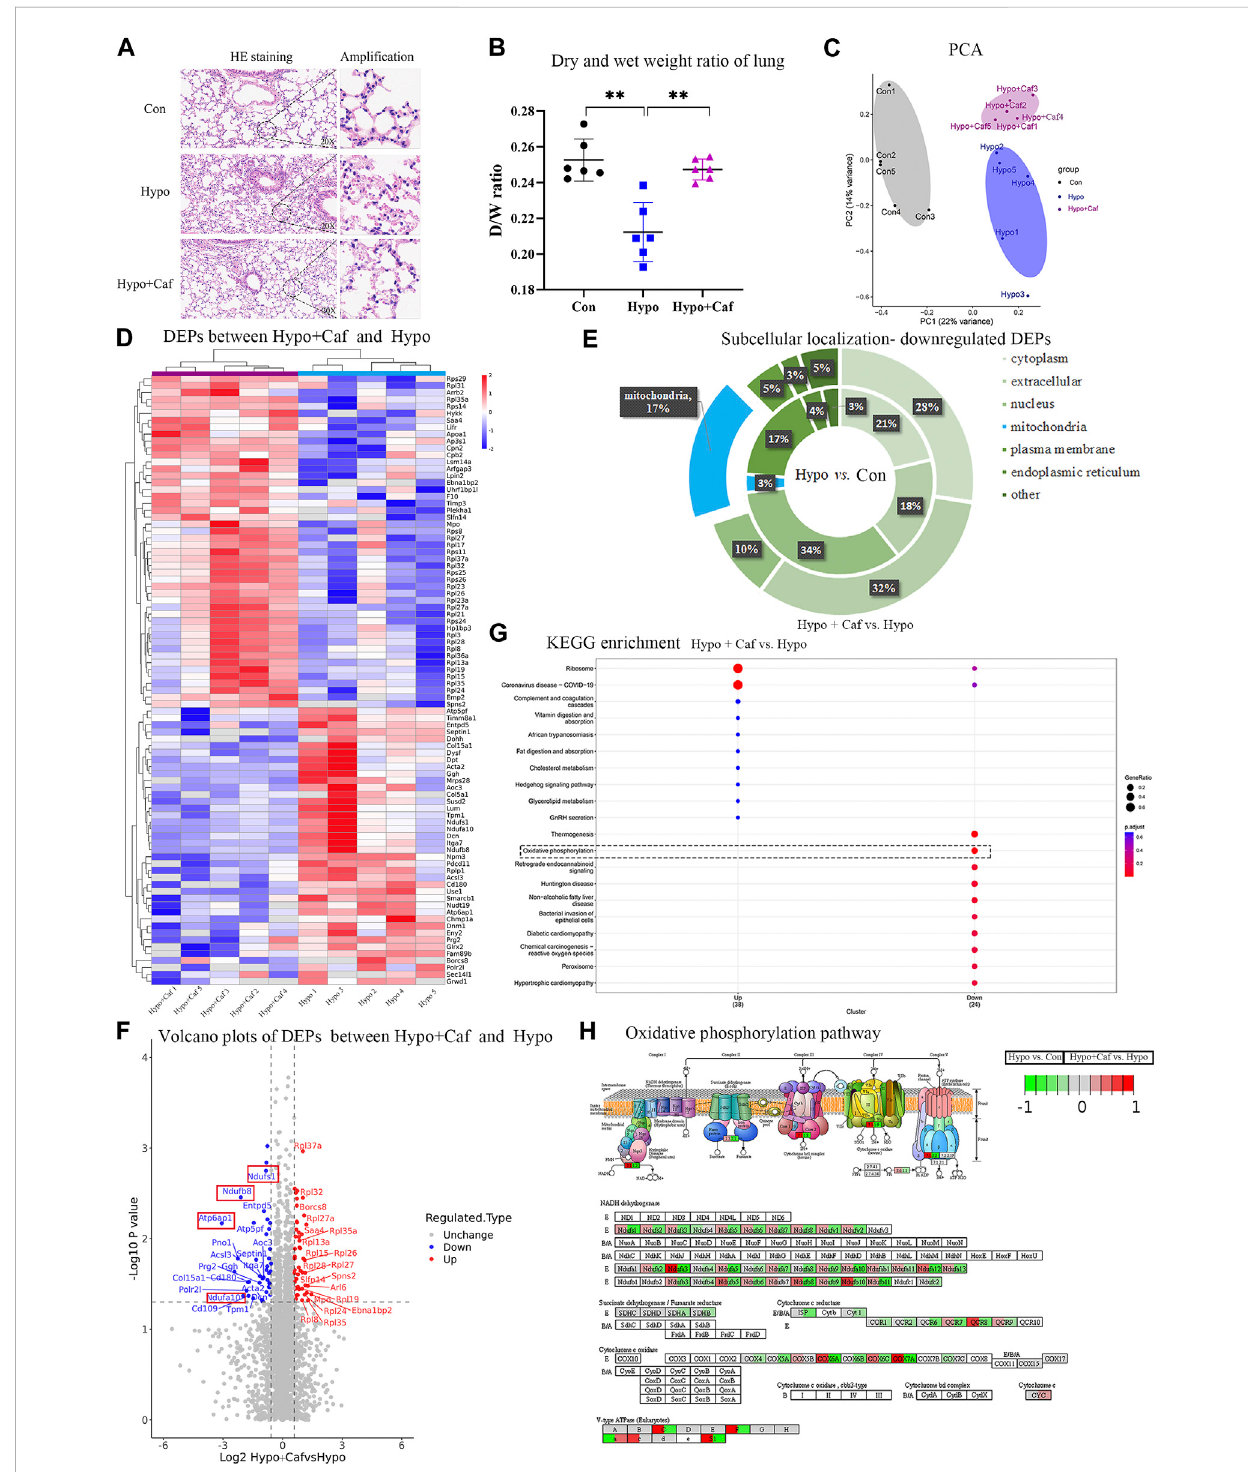
FIGURE 2 Caffeine alleviates HAPE by acting on mitochondria. (A) Images of hematoxylin and eosin – stained lung tissues. Hypoxia led to pulmonary congestionandalveolarstructuraldestruction,butcaffeinesuppressed thesedamages. (B) Dryandwetweightratiooflung.Thedryandwetweightratio of lung dramatically declines in Hypo group, suggesting the successful mice model of pulmonary edema model. Caffeine neutralized thedecrease in dry and wet weight ratio. (C) Principal component analysis of 15 samples based on the expression of all the proteins. These proteins could clearly separate the three groups from each other. (D) Heatmap of DEPs between Hypo and Hypo + Caf groups. The hierarchical clustering showed a clear separation of the two groups. (E) Subcellular localization of downregulated proteins. The internal ring refers to the subcellular localization ratio of DEPS between Hypo and Con group, while the external ring refers to the subcellular localization ratio of DEPS between Hypo + Caf and Hypo group. 3% of proteins localized to mitochondria (shown in blue) were downregulated in hypoxia. 17% of proteins localized to mitochondria were downregulated